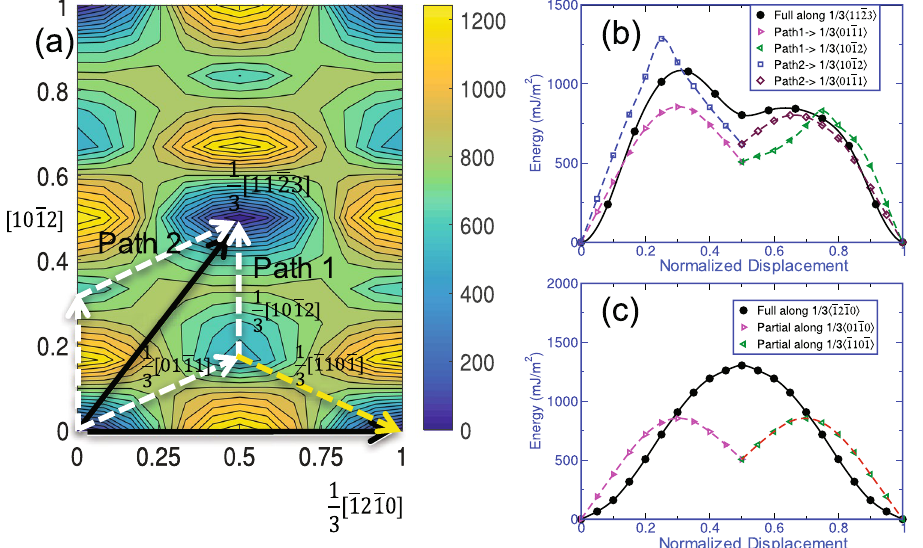
Figure 3. ( a ) Two-dimensional γ -surface for the pyramidal-I plane in ω -Zr obtained from DFT calculations. ( b ) The possible partial dislocations after dissociation of a full 〈 c + a 〉 dislocation on the pyramidal-I plane, and ( c ) the partial dislocations after dissociation of a full 〈 a 〉 dislocation on the pyramidal-I plane. The x-axis displacement shift corresponds to the actual displacement along the glide direction normalized by the full Burgers vectors for each slip system.